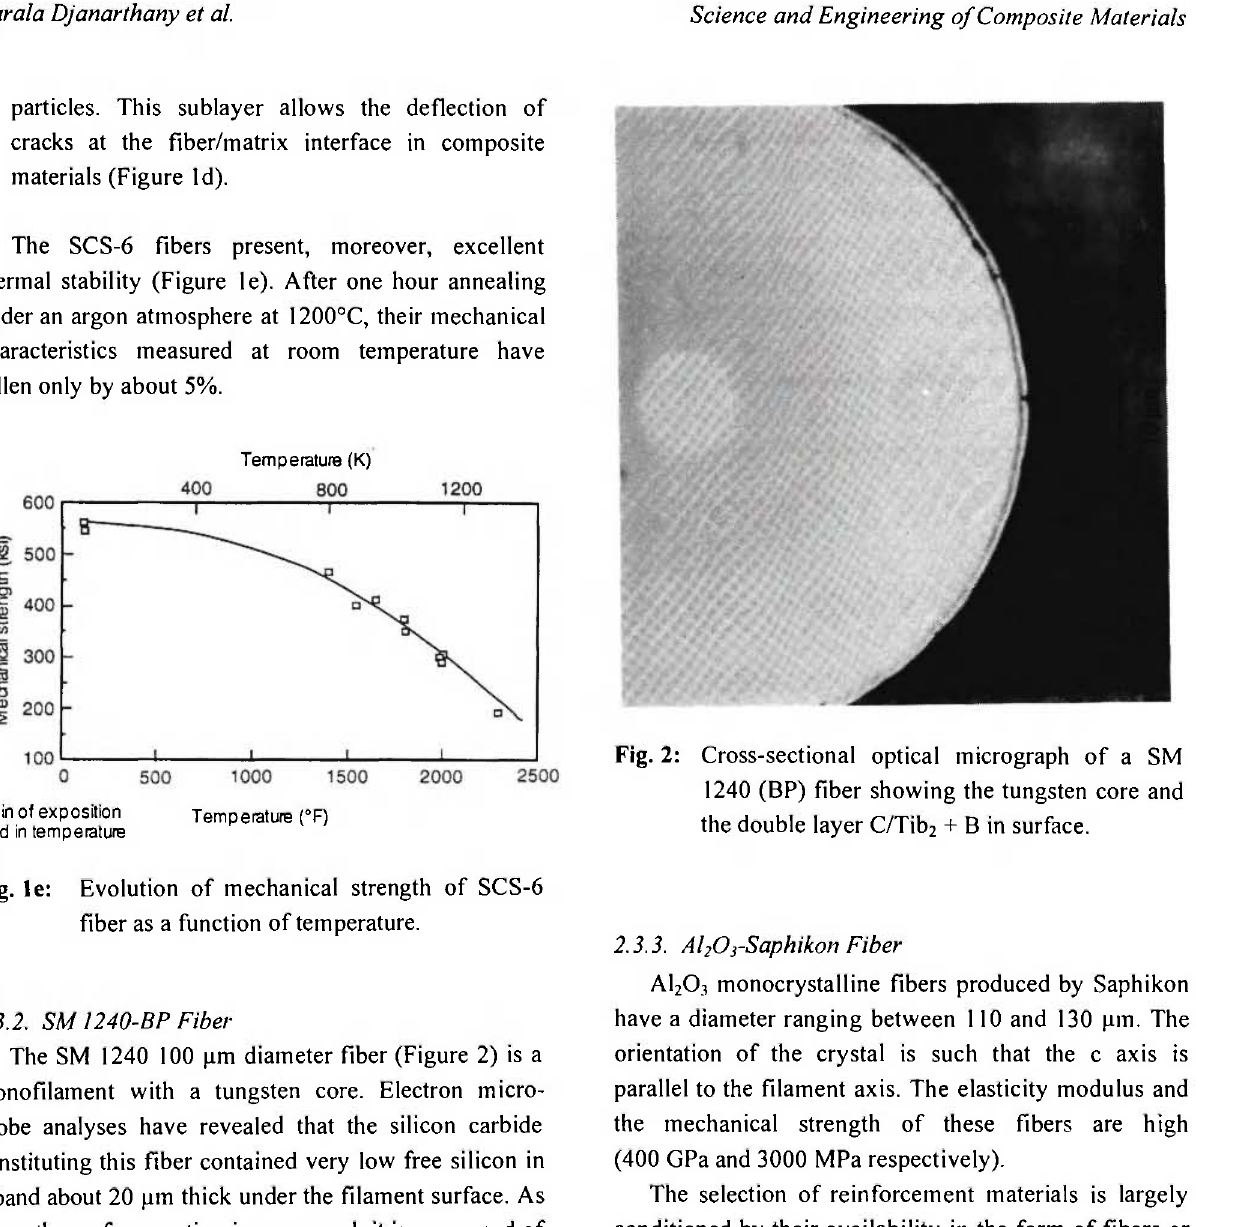
(400 GPa and 3000 MPa